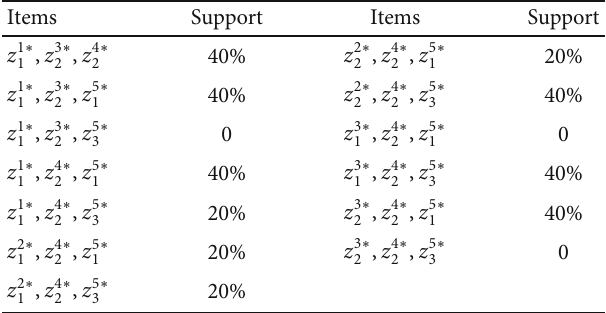
Table 8: Frequent item set L